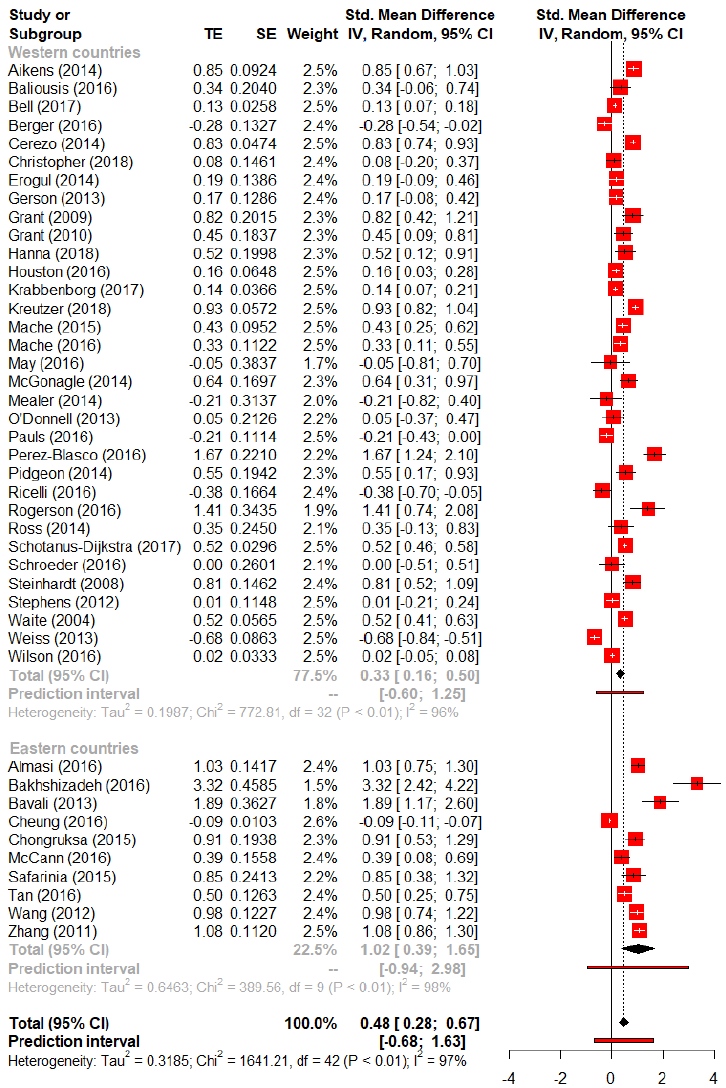
Figure 3. Forest plot for resilience.